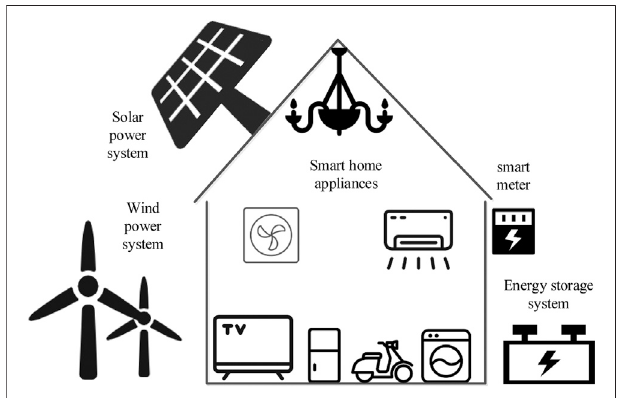
FIGURE 1 | Structure chart of the household new energy management